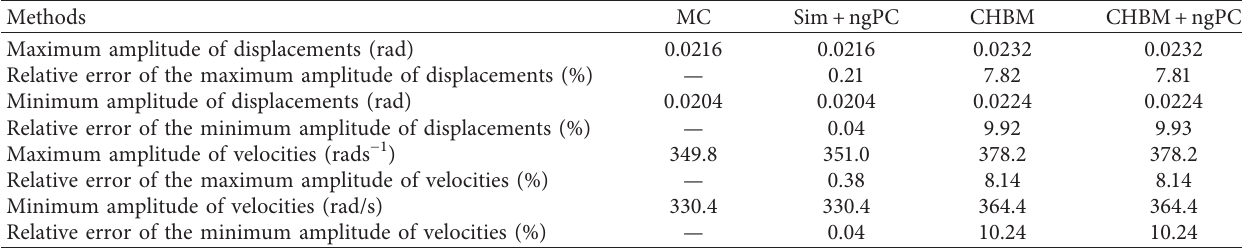
Table 4: Comparison of the limit cycles of a clutch system with several uncertain parameters between the MC method and the combination of the CHBM and ngPC: three different values of the friction coefficient and with different dispersions interval for uncertain parameters. Number of uncertain parameters r N Number of resolutions for the system of equations (see (13)) Relative error of the maximum amplitude of displacements